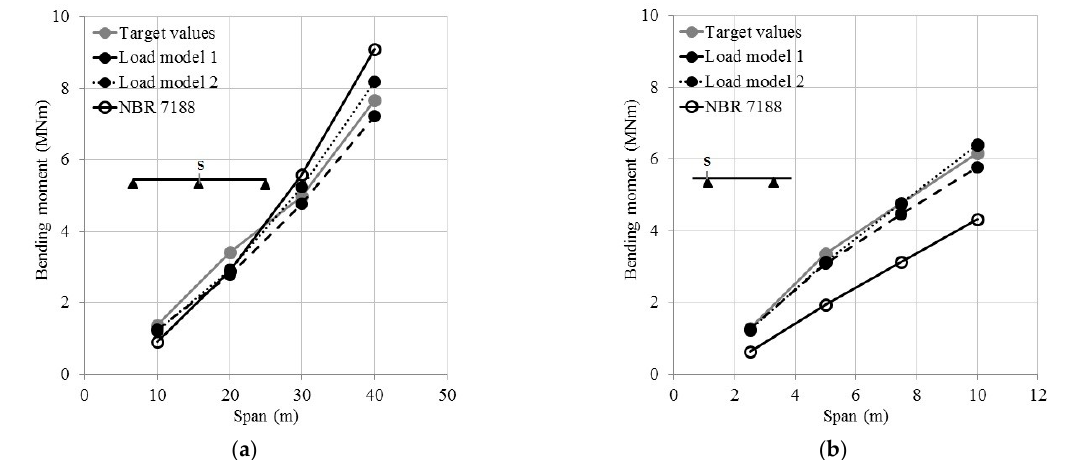
Figure 11. Comparison between the effects generated by the load models and the target values. ( a ) Negative moments on continuous bridges. ( b ) Negative moments on cantilevers.